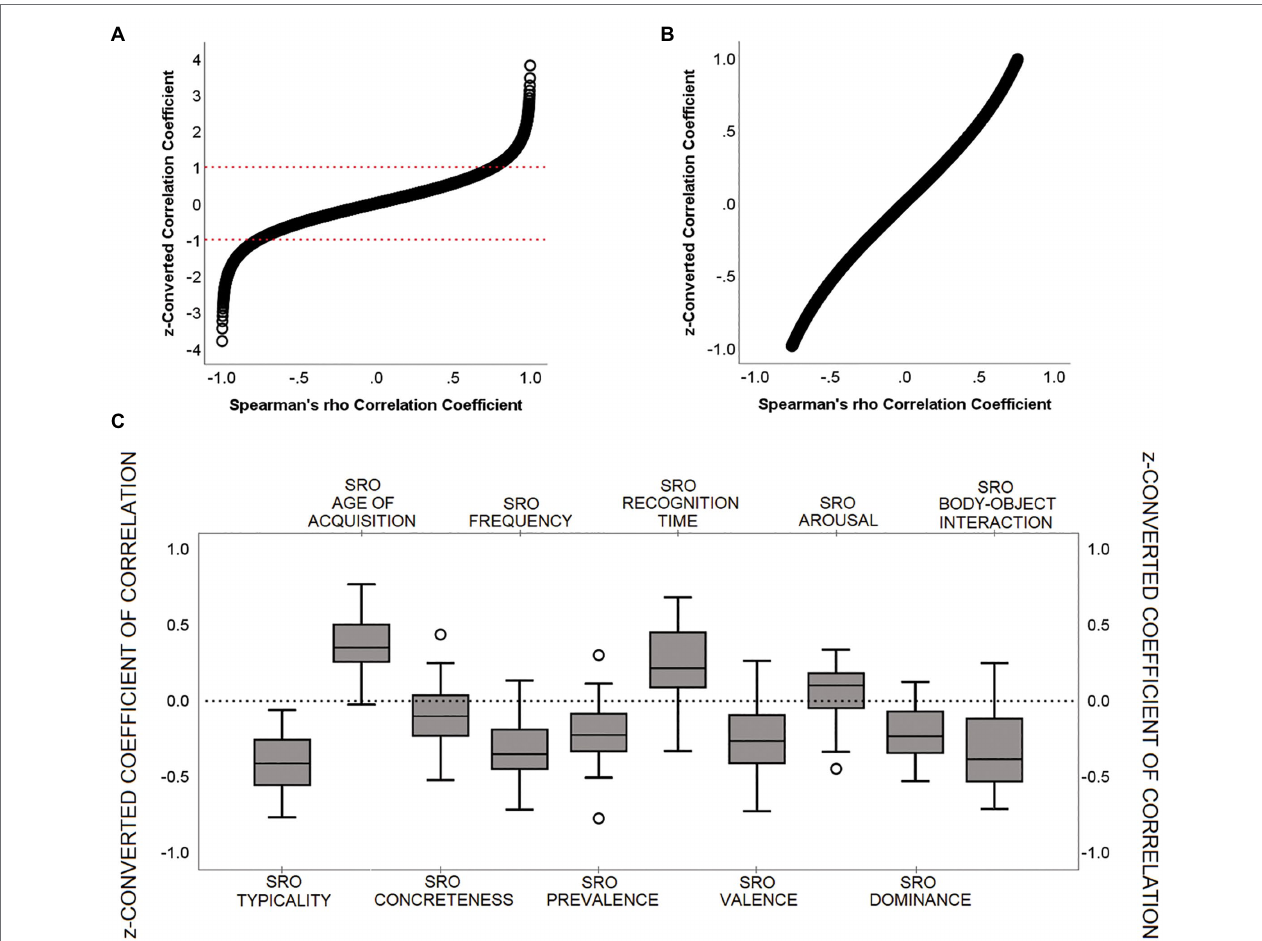
FIGURE 1 | Characterisation of ‘SRO-semantic feature’ z -converted correlation coefficients. (A) Association between Spearman’s rho (from − 0.999 to +0.999) and its z -score conversion; (B) Detail on the − 1 to +1 z -score interval; (C) Group distribution for each z -converted correlation coefficient. All individual scores ranged between − 1 and + 1. Within this interval, as can be seen in (B) , z -conversion does not produce major changes in the score distribution.